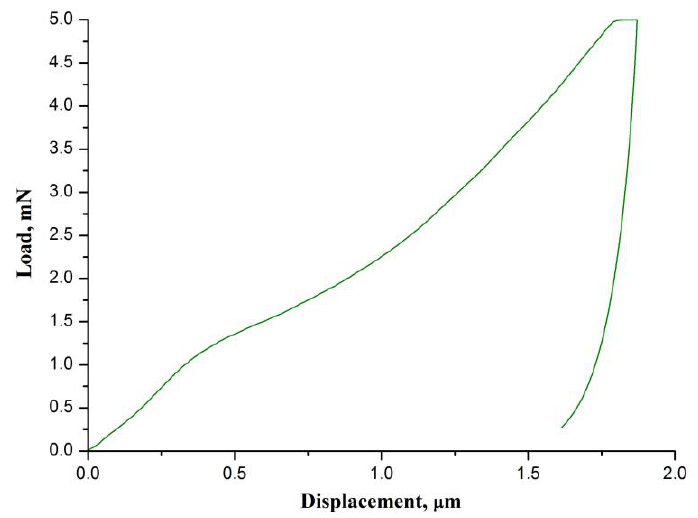
Figure 6. The normalized DTG signals of CaO nanofiber carbonation and decarbonation processes. The calculated values of hardness and the indentation Young’s modulus are 1.87 ± 0.05